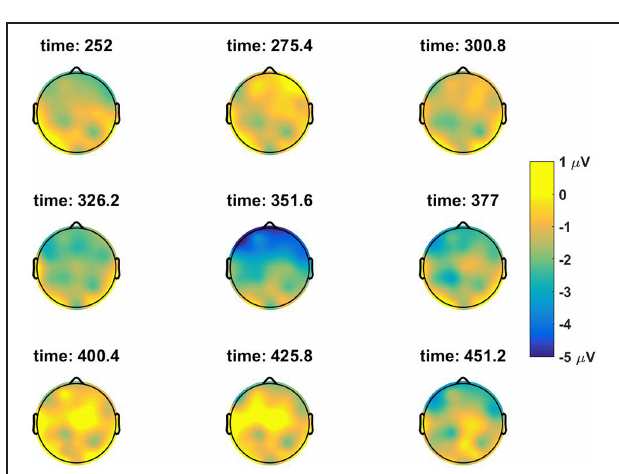
FIGURE 1 | Mean waveform at first potential antecedent Lodewijk position for No-constraint Match and Mismatch conditions.